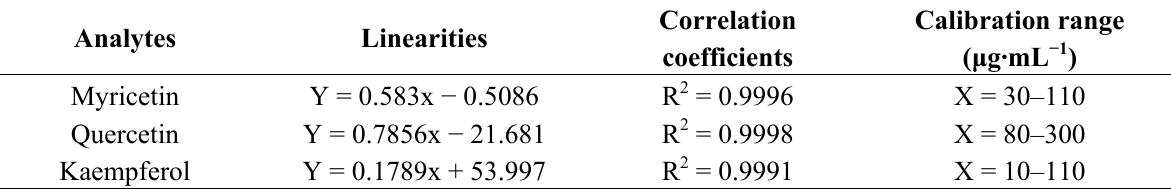
Table 2. Calibration curves of the proposed